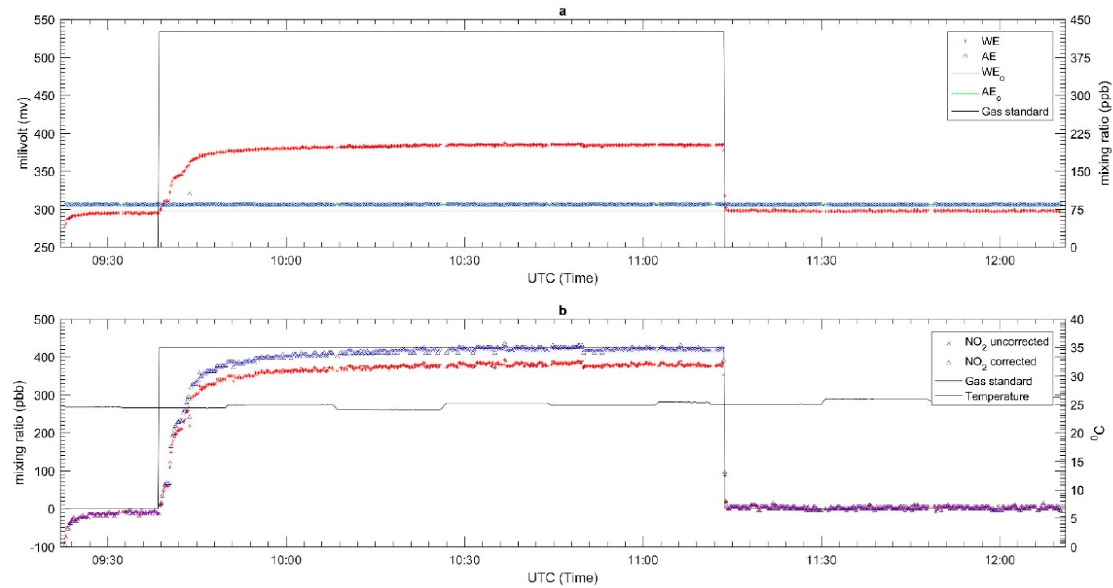
Figure 10. The laboratory calibration of NO 2 -A43F EC sensor ( a ) the electrode signal along with the gas standard and ( b ) The signal converted to mixing ratio and temperature.